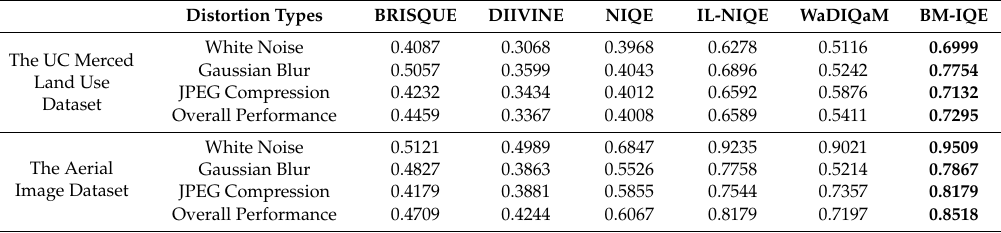
Figure 9. Samples of blur images from the built remote sensing image database. The degradations gradually increased from ( a – d ), and the corresponding quality scores obtained with BM-IQE are given as 15.5828, 18.2615, 25.0430, 28.0898, respectively. Table 4. Overall SROCC values of NR-IQA algorithms on remote sensing